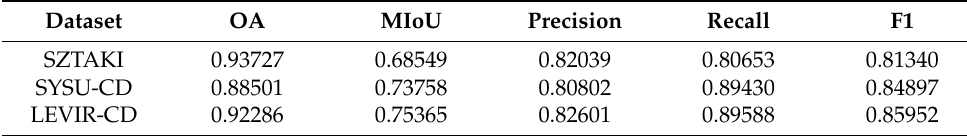
Table 5. The experiment results of bi-attention SFA on three standard